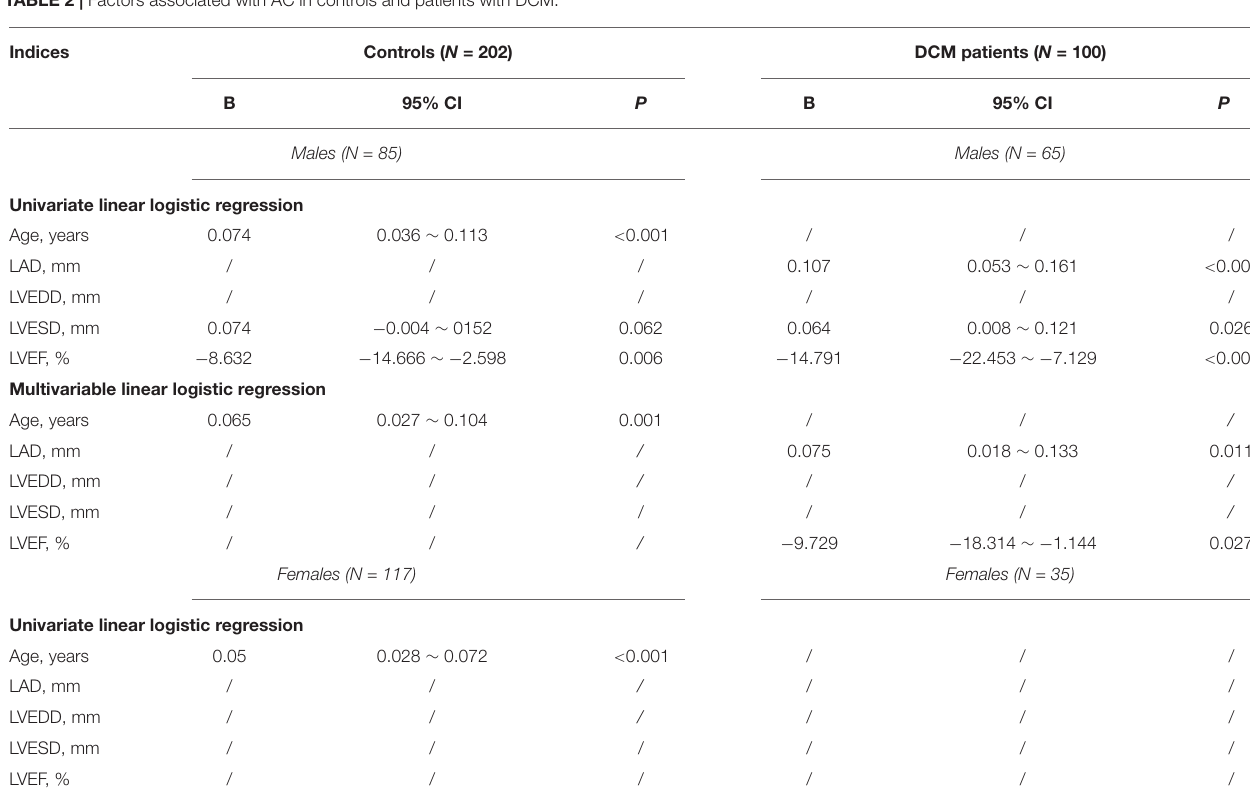
TABLE 2 | Factors associated with AC in controls and patients with